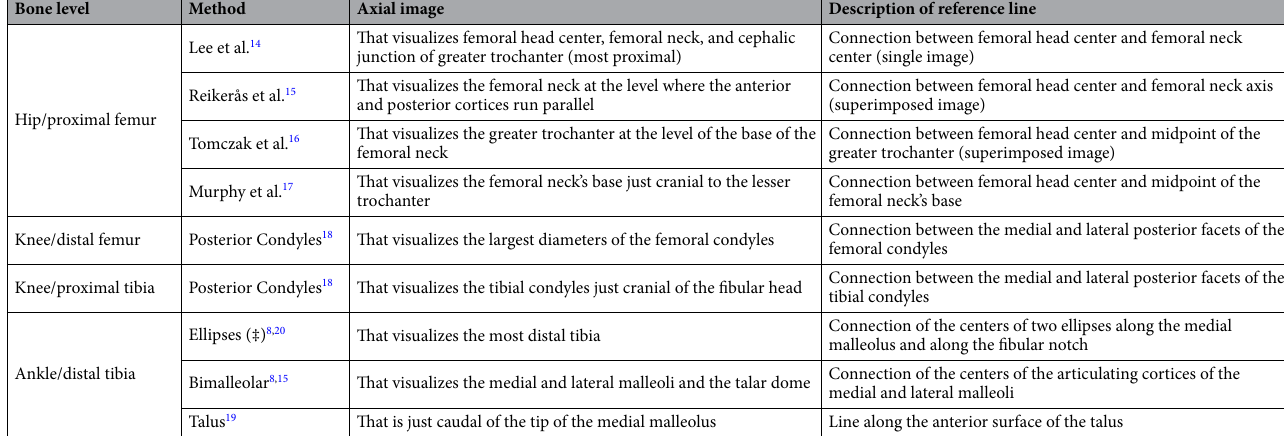
Table 3. Description of the methods for manual definition of femoral and distal reference lines as modified from 8,10 . For the reference lines at the knee and ankle, descriptive terminology (instead of the first